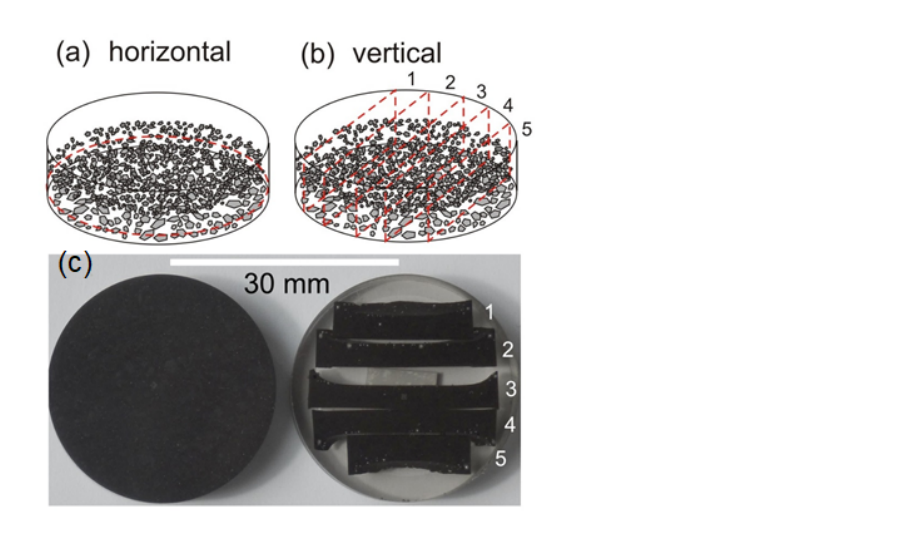
Figure 1. Horizontal and vertical grain mounts of ashes. Gravitational settling might lead to a bias in ash analysis, vertical preparation helps address this bias. ( a ) Horizontal section with polishing plane indicated by red stippled line. ( b ) Vertical section with slices 1–5 of vertical cuts, indicated by red stippled lines. ( c ) Polished surfaces of grain mount blocks with graphite-loaded epoxy raisin; horizontal cut to the left and embedded vertical cuts 1–5 to the right. Table 1. Number of particles and grains measured per sample, per preparation type.